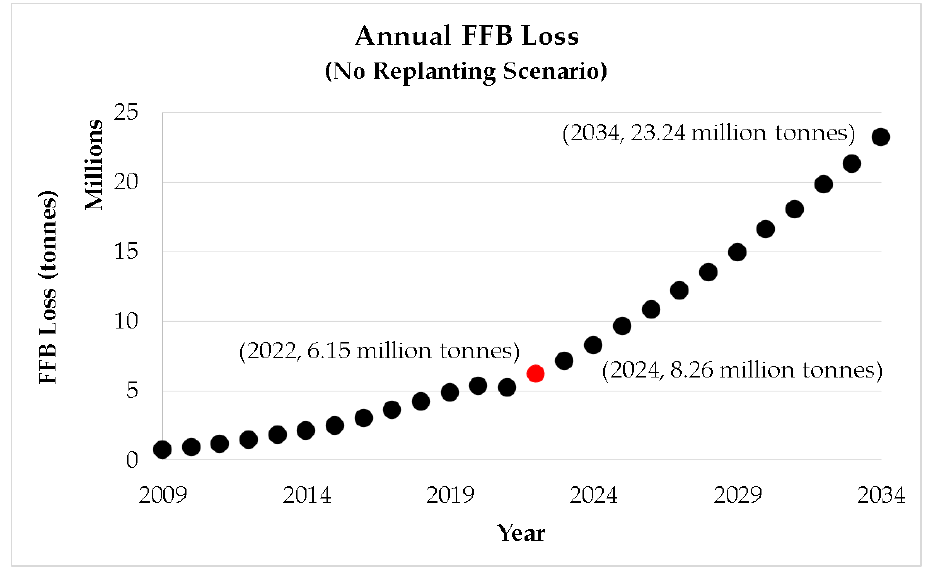
Figure 7. Minimum annual FFB losses due to ageing of oil palm crops (no replanting scenario).